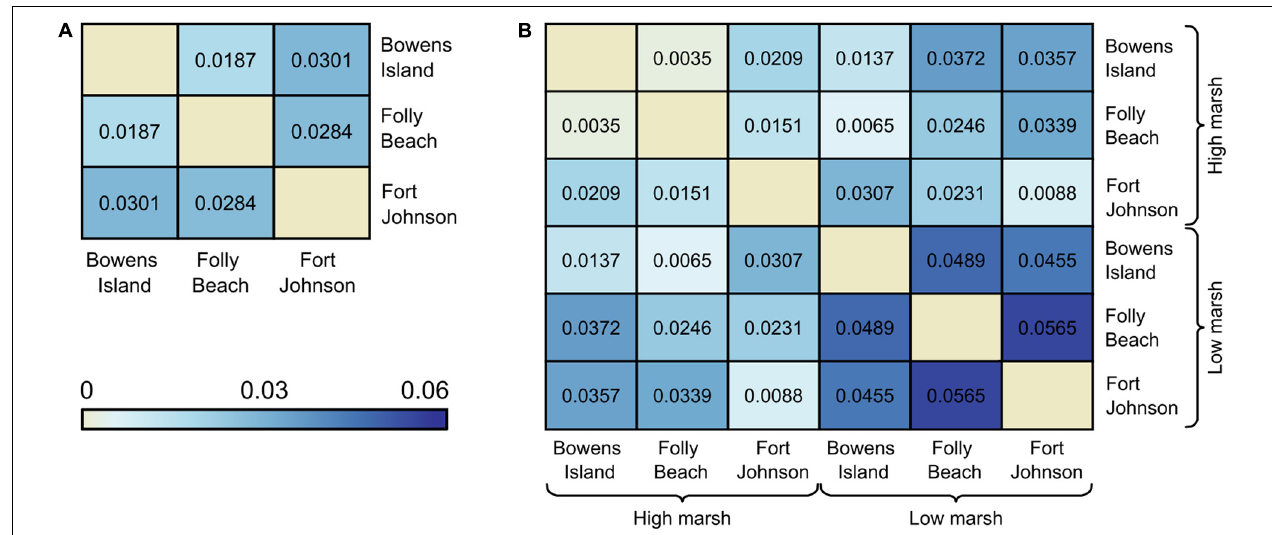
FIGURE 3 | Pairwise F ST values (A) among field populations of Spartina alterniflora , and (B) between habitats (low marsh and high marsh) within populations. All values were significantly genetically differentiated pairs based on 95% CI.